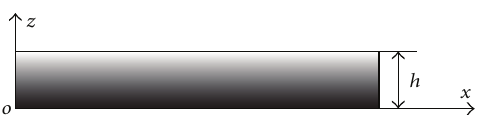
Figure 1: FGM plate and Cartesian